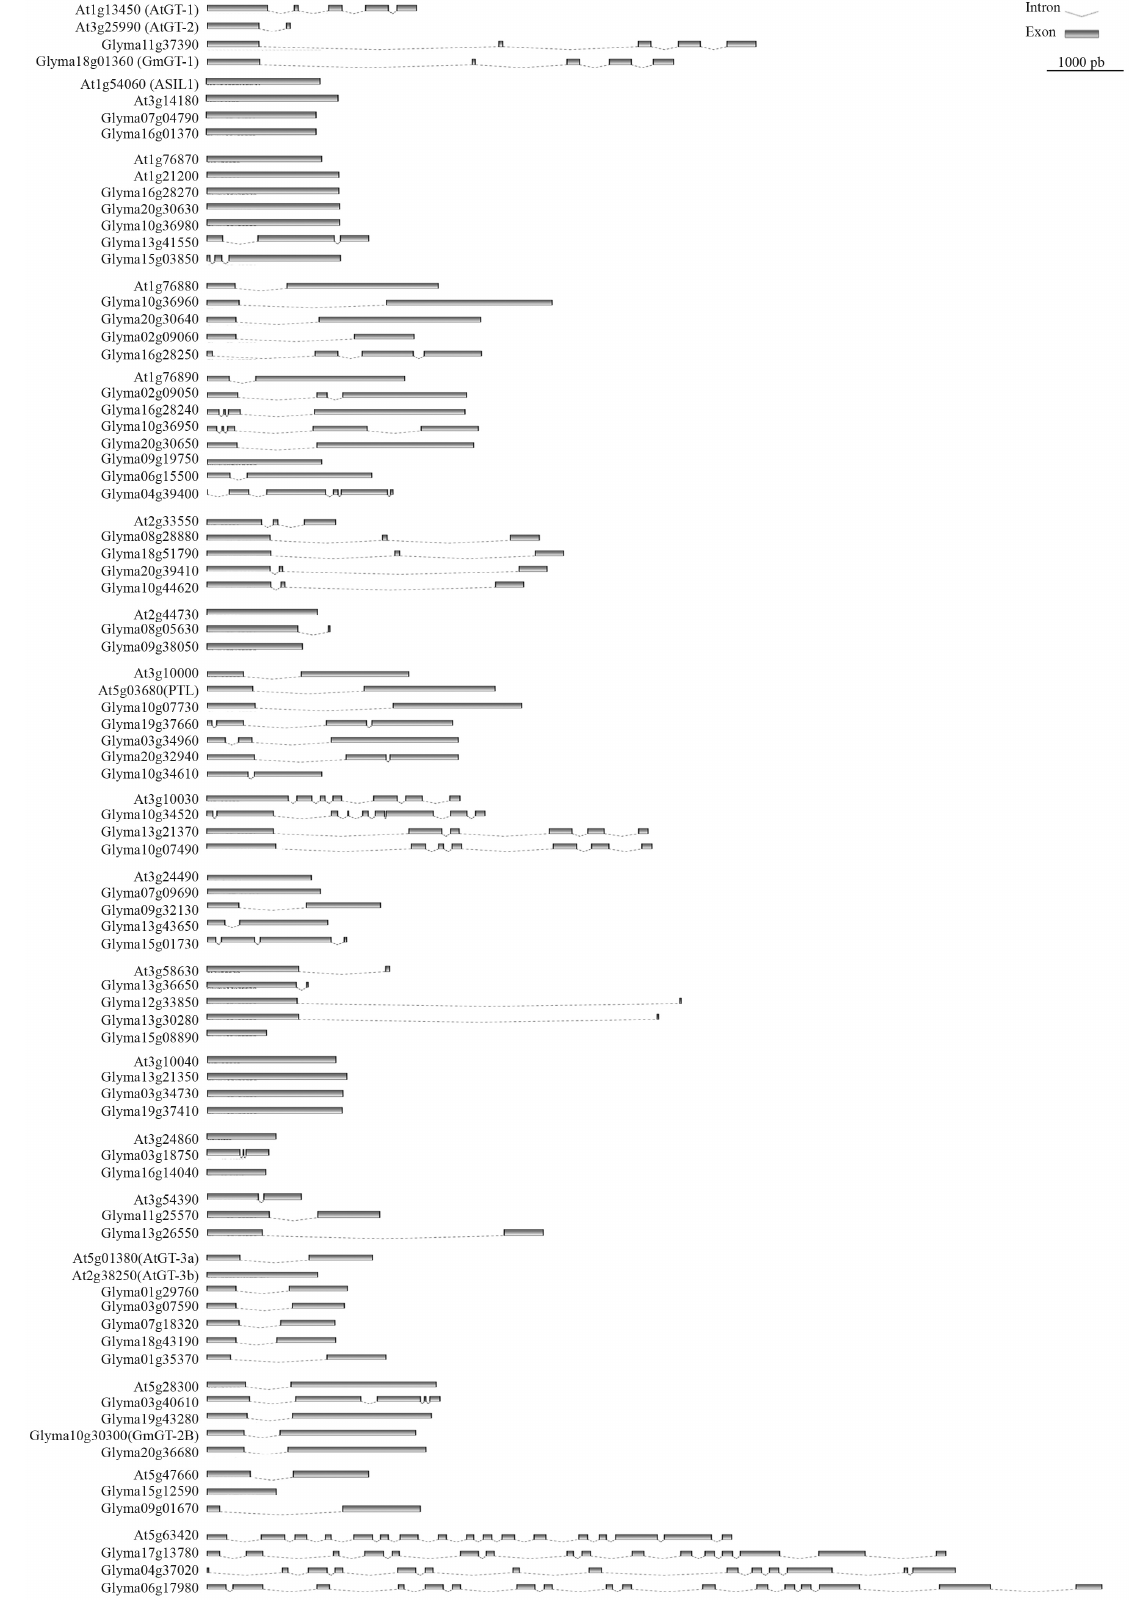
Figure 5 - Gene organization of phylogenetically related full-length coding sequences from Arabidopsis and soybean trihelix-GT transcription factors. Intron-exon maps were drawn using Fancy Gene ver. 1.4